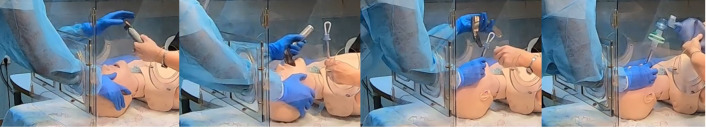
Endotracheal intubation using the barrier box.